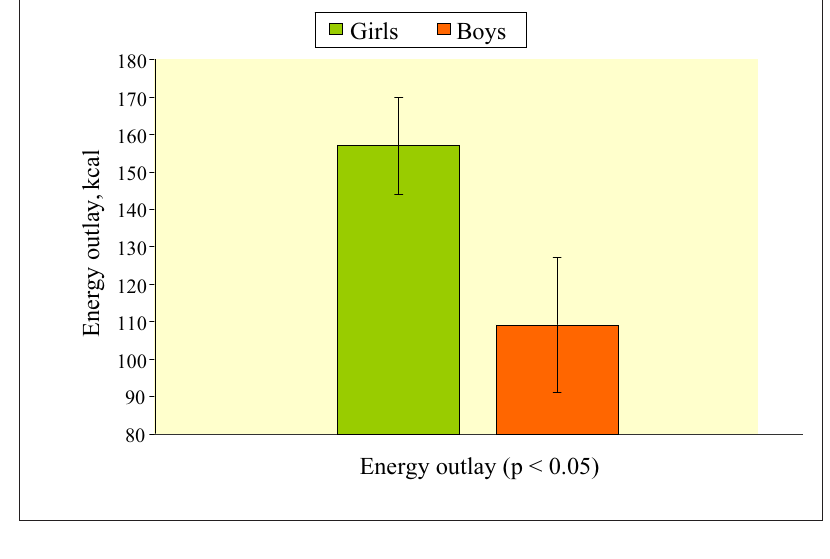
Figure 2. Energy outlay of juvenile sports dancers (kcal) during a 10-min